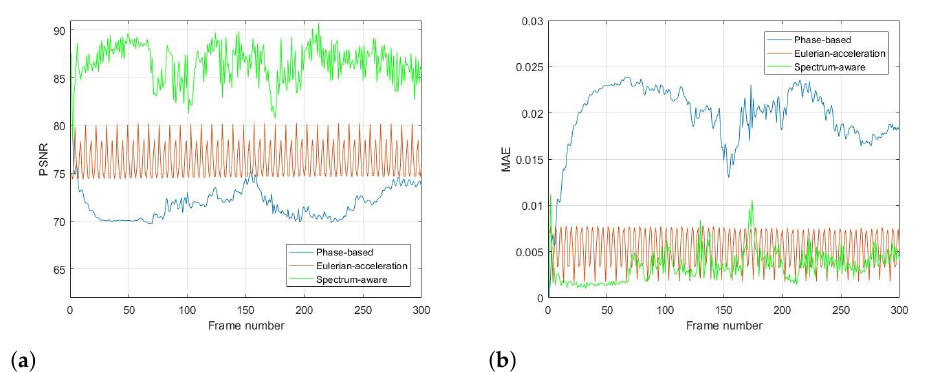
Figure 13. Objective metrics with ground truth for each magnification processing using ( a ) PSNR and ( b ) MAE in synthetic